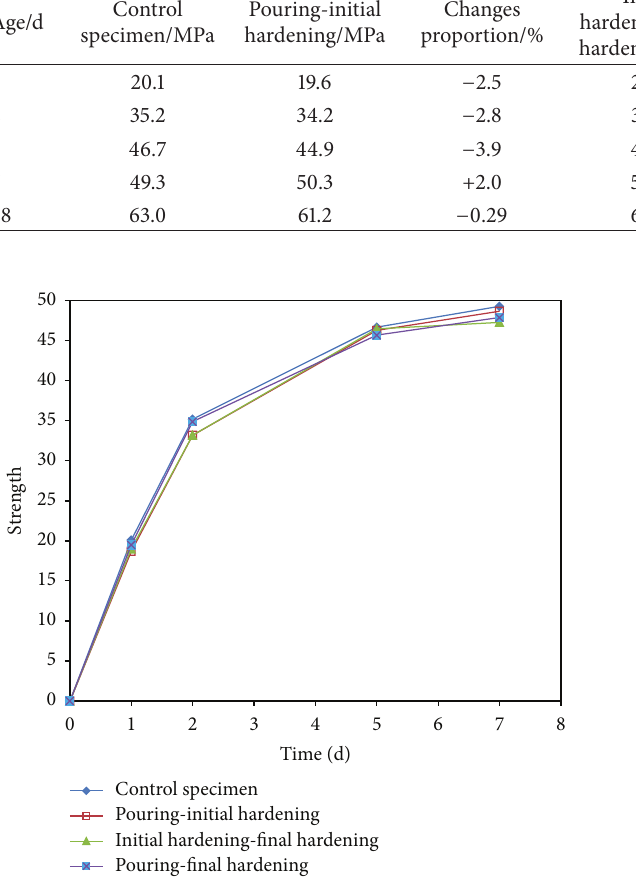
Figure 6: Compressive strength and rate of change of HPC speci- mens with vibration parameters of 4Hz and 3mm.